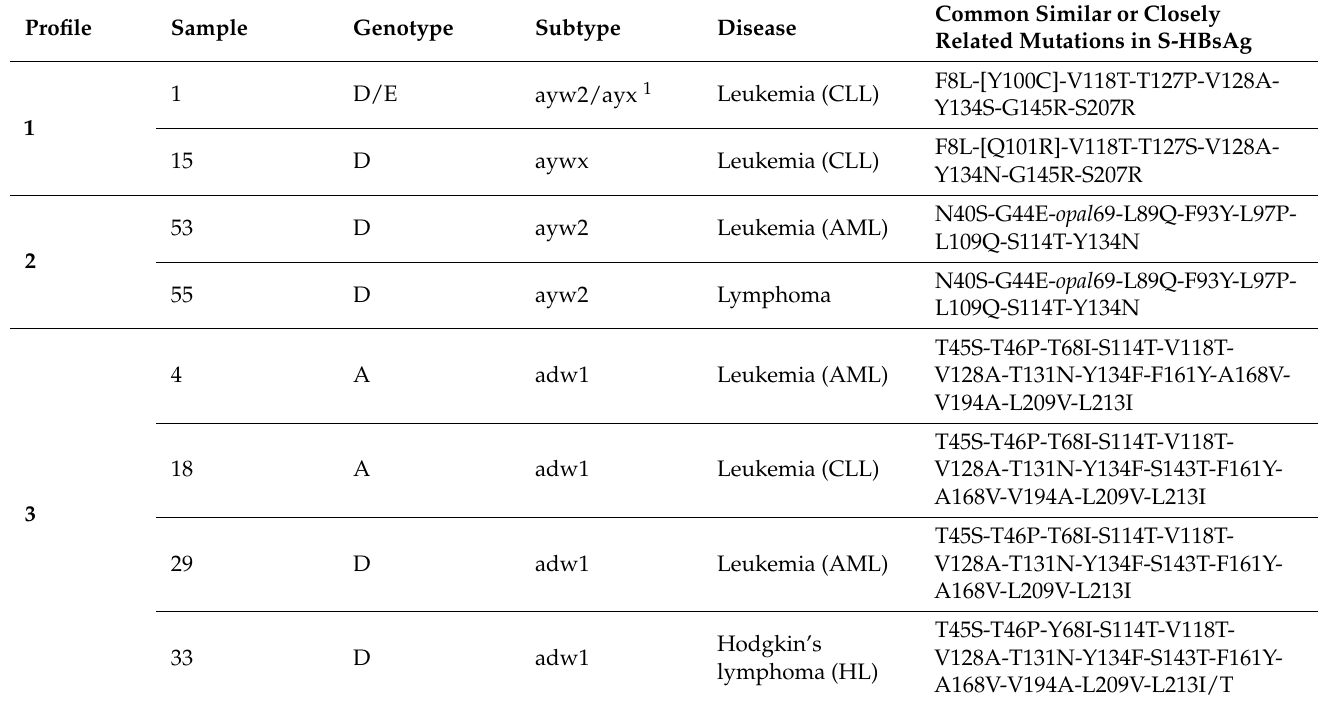
Table 5. Mutation profiles (linked mutations) of HBV in hematological cancer